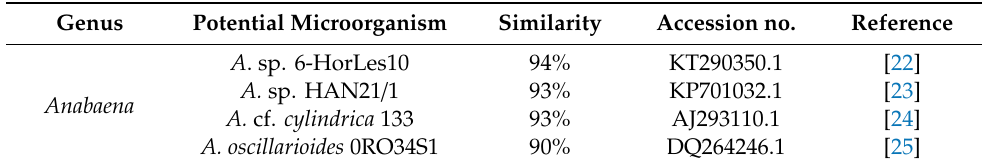
Table 1. Microorganisms similar to the homologous 16S rRNA gene specific for cyanobacteria (GenBank, NCBI).